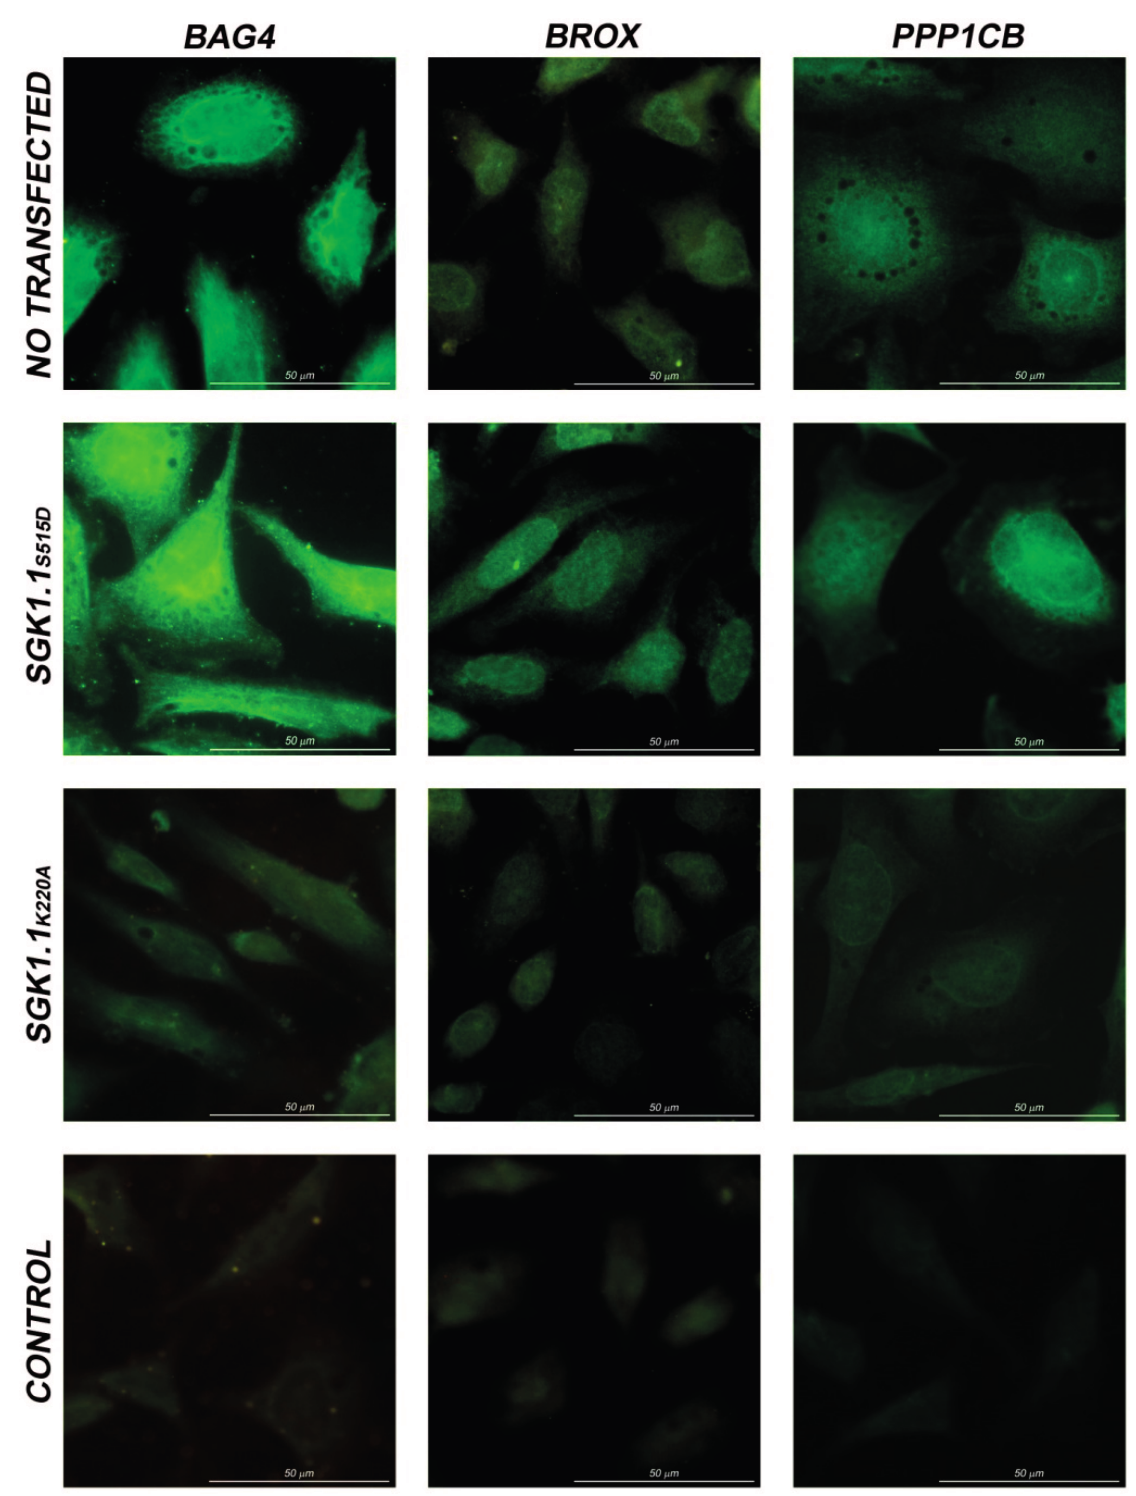
Figure 4. Immunolocalization of BAG-4, Brox and PPP1CB in non-transfected HeLa cells and SGK1.1S515D or SGK1.1K220A transfected HeLa cells. Negative control for secondary antibody at the same exposure time of the corresponding